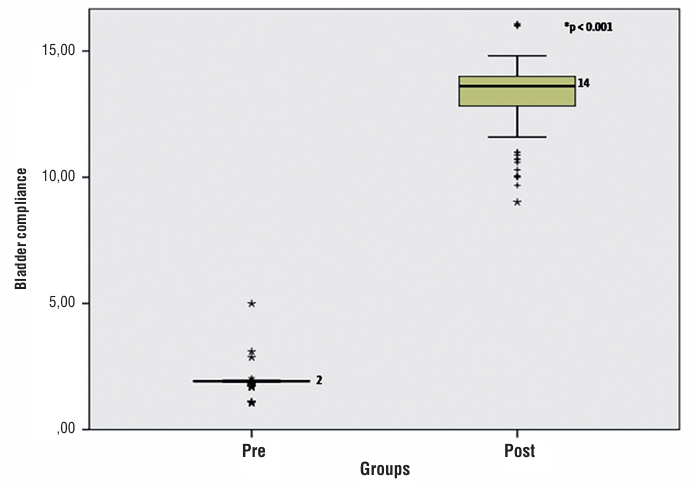
Figure 3 - Comparison of preoperative and postoperative bladder